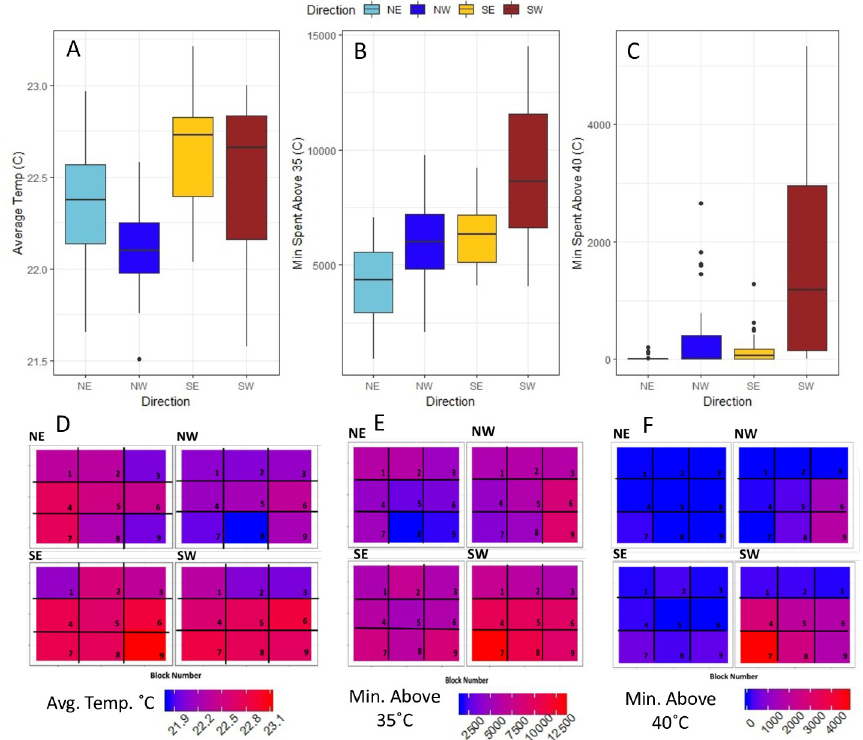
Fig 2. Nest cavity temperatures by the direction the nest cavity was facing. (A) Average temperature, (B) amount of time spent above 35˚C during the filed season, (C) amount of time spent above 40˚C during the field season. (D-F) Heat maps correspond to each direction the nest cavities were facing and each side divided into nine regions that correspond to the iButtons. (D) Average temperature, (E) amount of time spent above 35˚C during the filed season, and (F) amount of time spent above 40˚C during the field